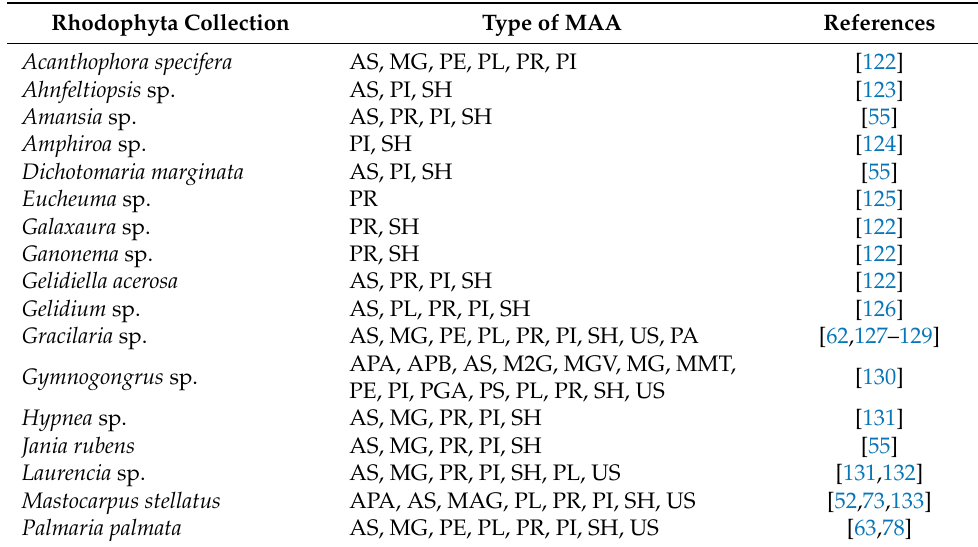
Table 4. Red seaweeds of Indonesia as potential MAAs producers.